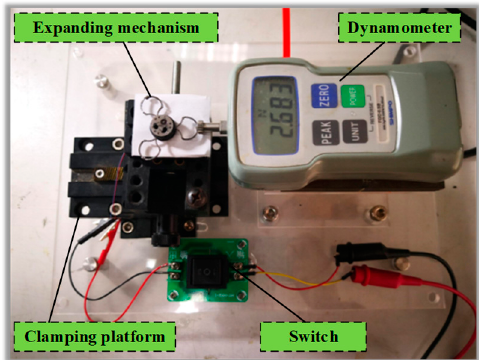
Figure 18. Mechanical performance test platform.